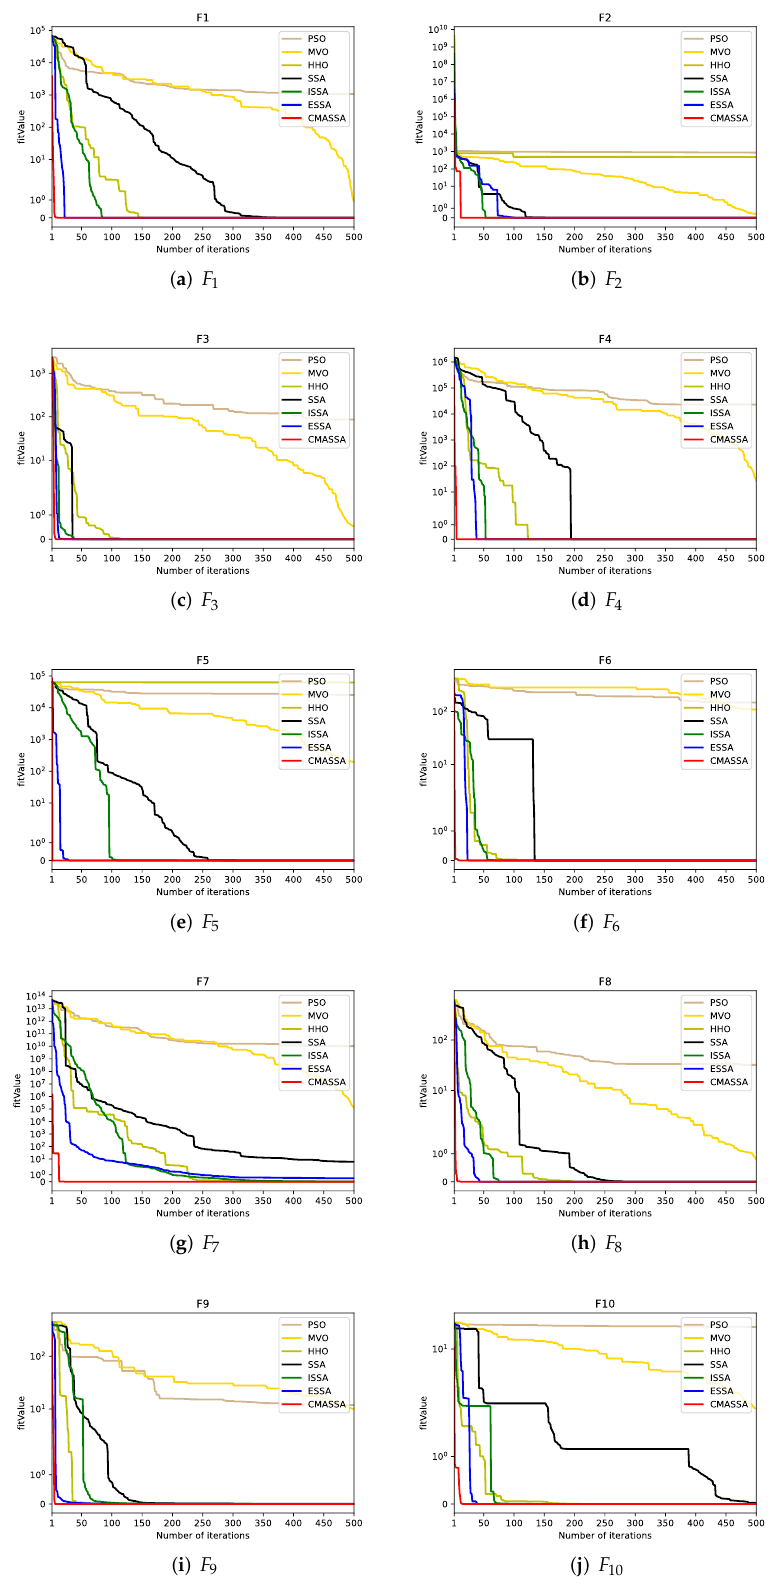
Figure 7. Convergence curves of seven algorithms on ten test